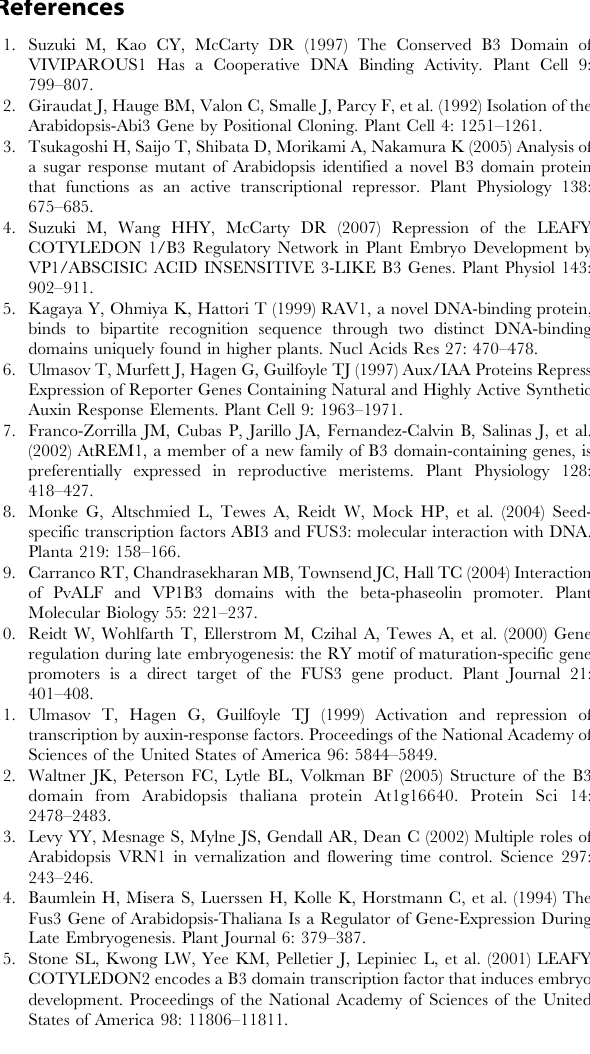
Table S3 Populus trichocarpa B3 gene list. Gene ID and additional information about poplar B3 genes used in this study. The source for all sequences was the JGI data bank. Table S4 Orysa sativa B3 gene list. Gene ID and additional information about rice B3 genes used in this study. The source for all sequences was the TIGR data bank. Asterisks denote protein not found by Swaminathan et al. [30].